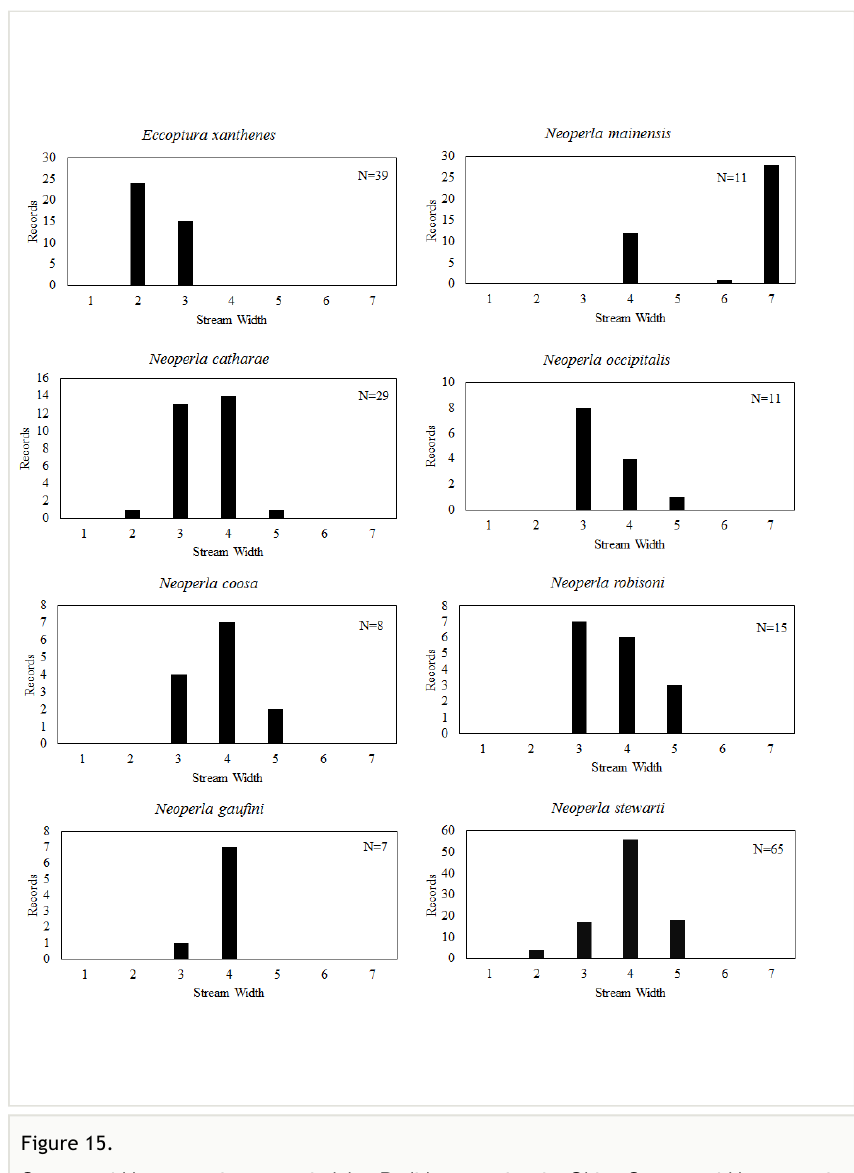
Figure 15. Stream width categories occupied by Perlidae species in Ohio. Stream width categories: 1=seep, 2=1-2 m, 3=3-10 m, 4=11=30 m, 5=31-60 m, 6=>60 m, 7=Lake